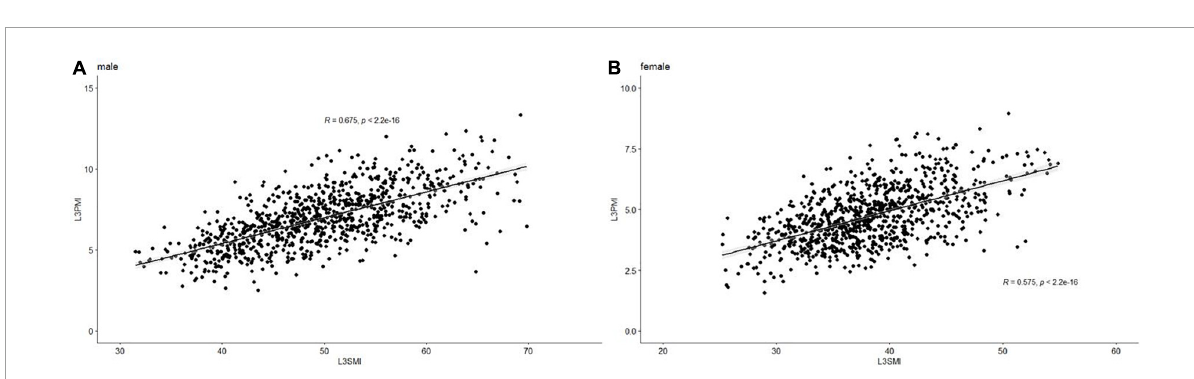
FIGURE3 The relationship between L3-PMI and L3-SMI in (A) male and (B) female. Data are analyzed using the Pearson correlation